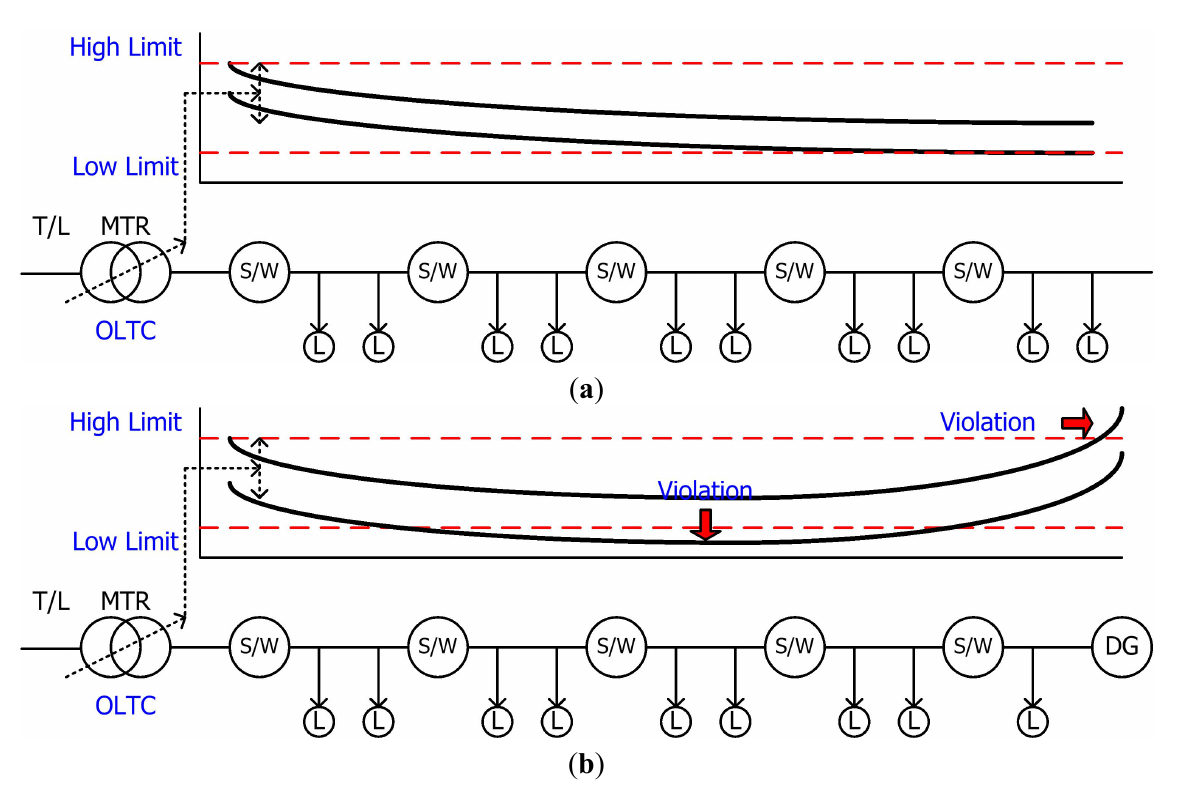
Figure 1. Challenges of total distribution automation system (TDAS): ( a ) non-distributed generator (DG) interconnected distribution network; and ( b ) DG interconnected distribution